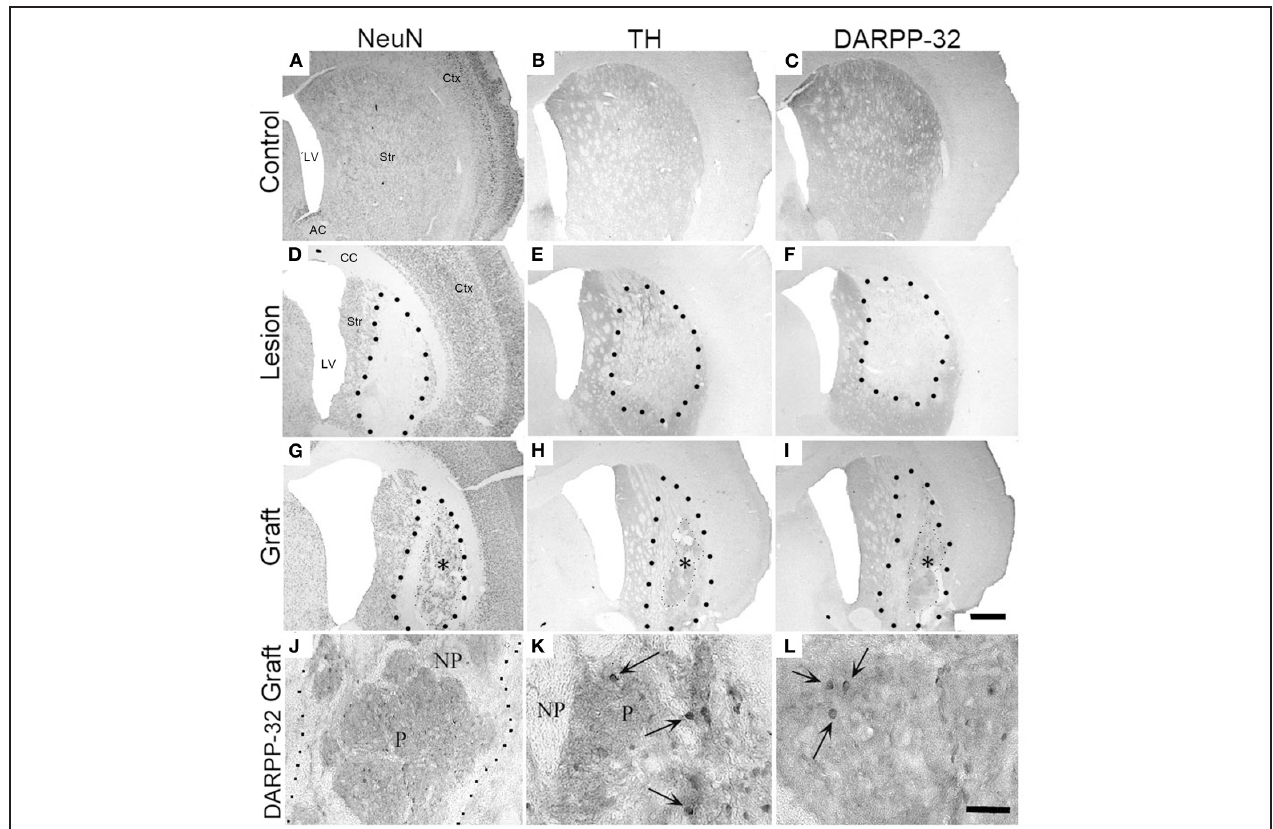
striatum with striatal-like neurons aggregating into patches (H, I) . Larger black dots delineate lesioned vs. intact striatum interface; smaller black dots show graft vs. host interface. (J–L) High magnification images of DARPP-32 positive cells from the P-zone of grafted animals. Arrows indicate individual DARPP-32 positive grafted neurons. Histology was done 35 weeks post-grafting. P, patch; NP, non-patch. Scale bar in I = 1mm; scale bar in L